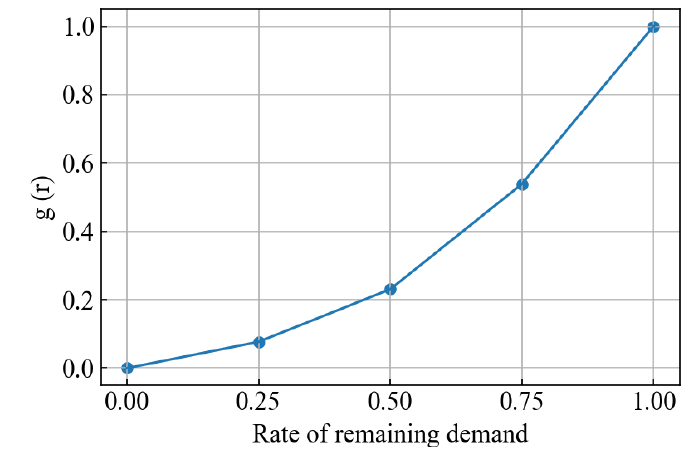
Figure 3. The disutility function for unsatisfied